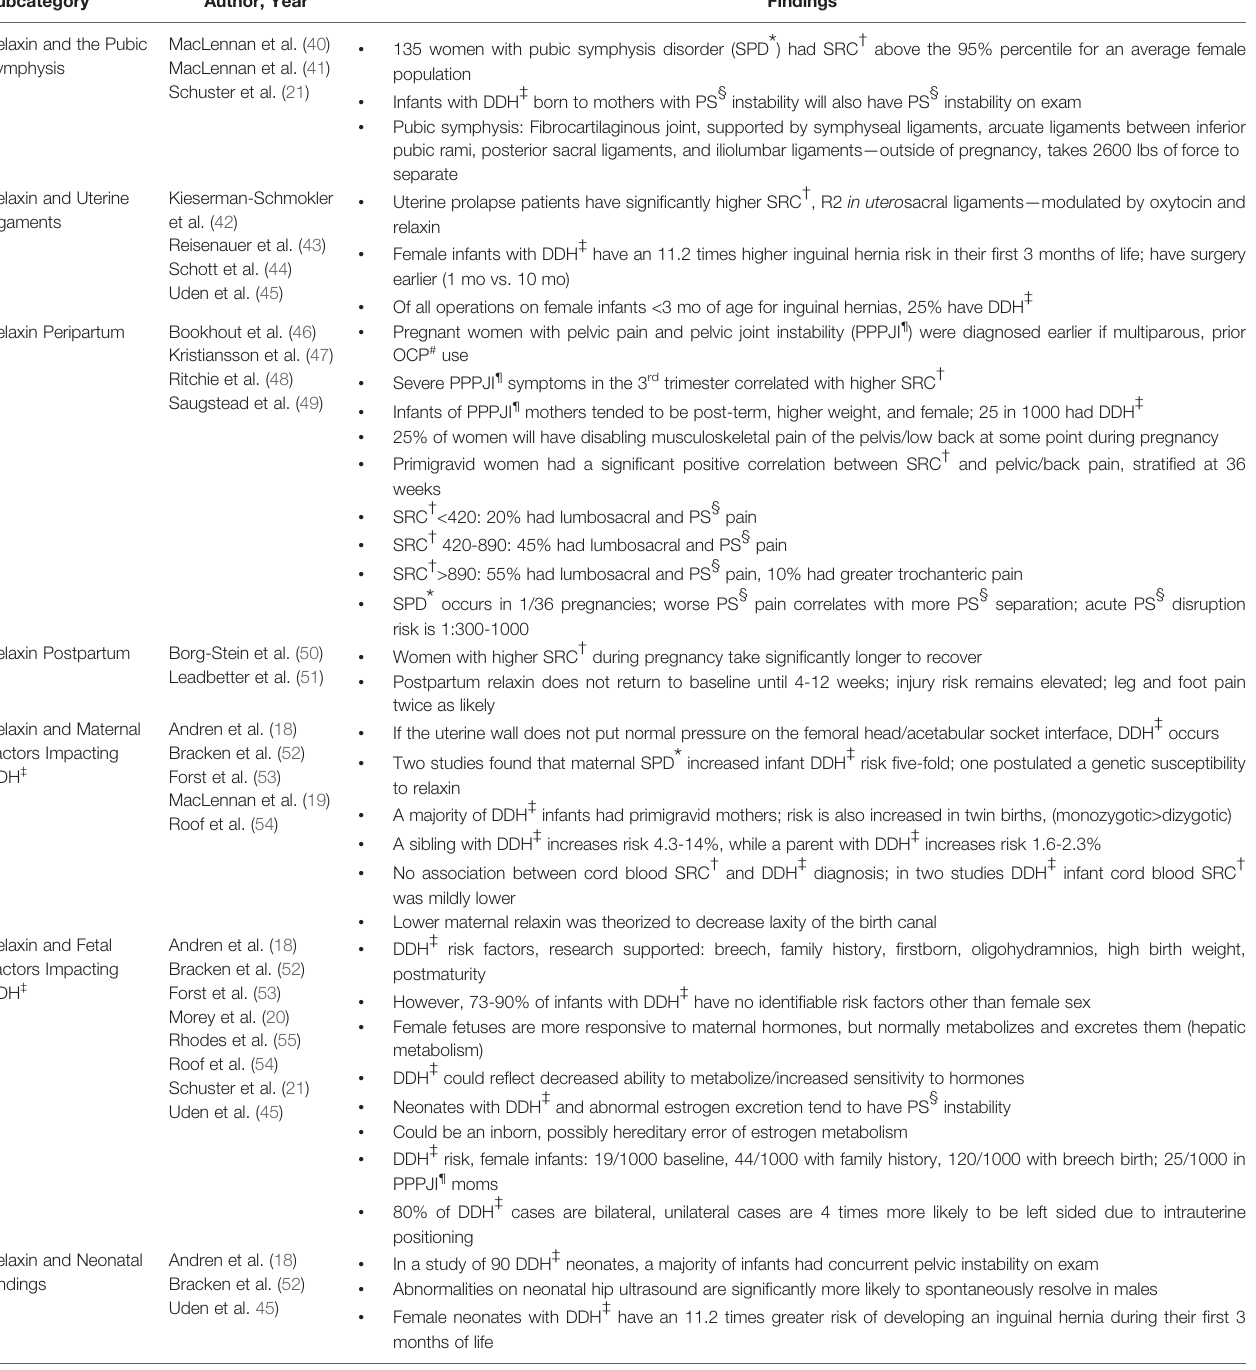
TABLE 4 | Pelvic and hip joint related effects of relaxin- relevant literature fi ndings.